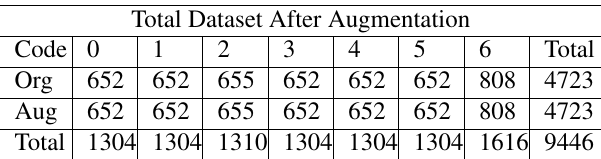
Table 1. Final Dataset after Augmentation